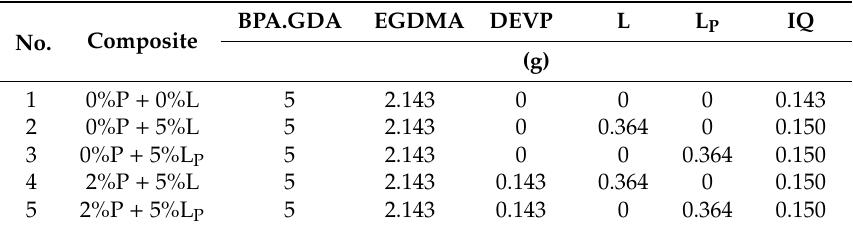
Table 8. Experimental parameters of the